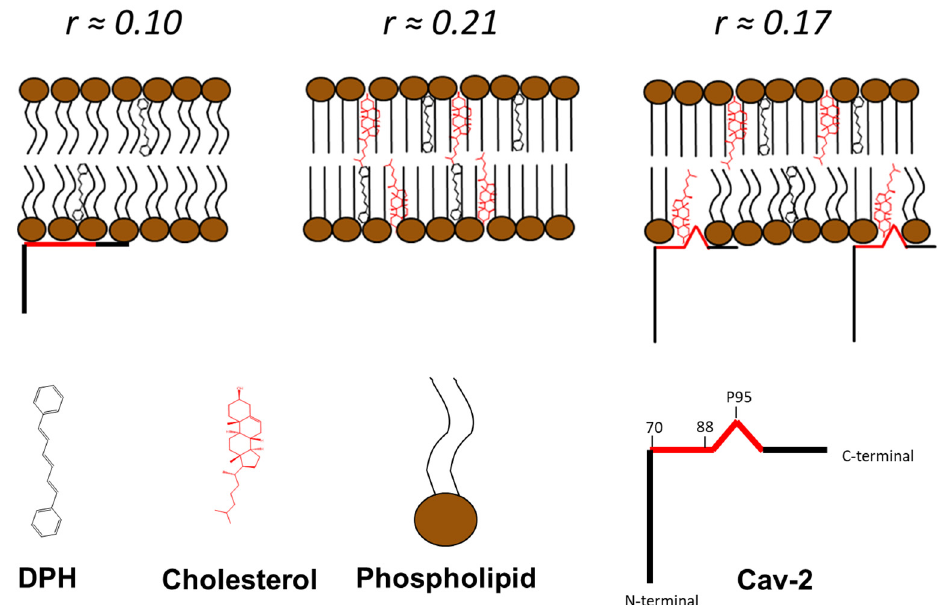
Figure 6. The scheme of the cholesterol redistribution in the membrane induced by Cav-2 is based on steady-state anisotropy experiments.